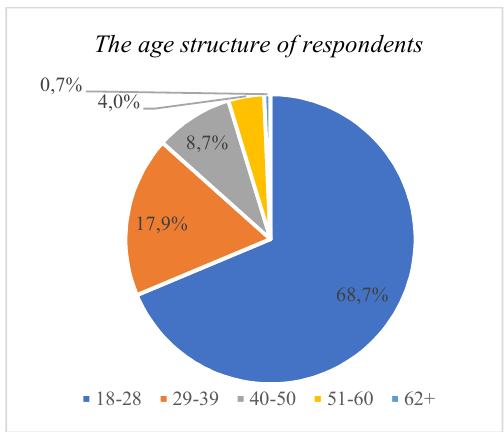
Figure 5. The age structure of respondents